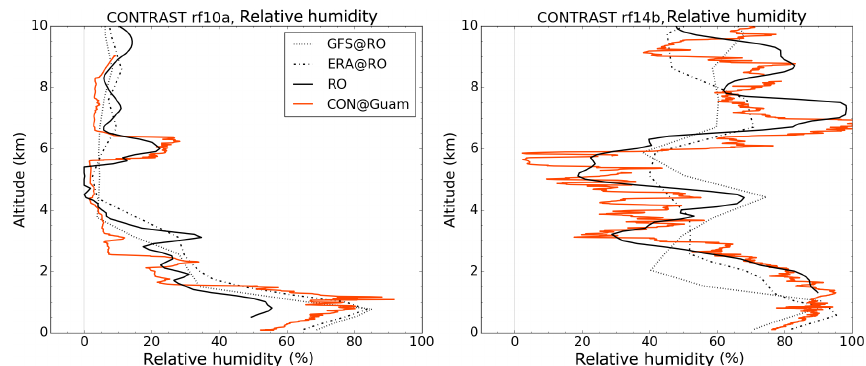
Figure 3. RH profile for CONTRAST (solid orange), RO (solid black), and RO-collocated profiles (ERA: dashed-dotted black; GFS: dotted black). Profile times and locations: CONTRAST (left) on 8 February 2014, 00:17–00:32UT, at 13 . 5 ◦ N, 144 . 8 ◦ E; RO (left) on 7 February 2014, 22:57UT, at 13 . 9 ◦ N, 148 . 1 ◦ E. CONTRAST (right) on 22 February 2014, 09:09–09:35UT, at 13 . 5 ◦ N, 144 . 8 ◦ E; RO (right) on 22 February 2014, 12:06UT, at 15 . 6 ◦ N, 148 . 1 ◦